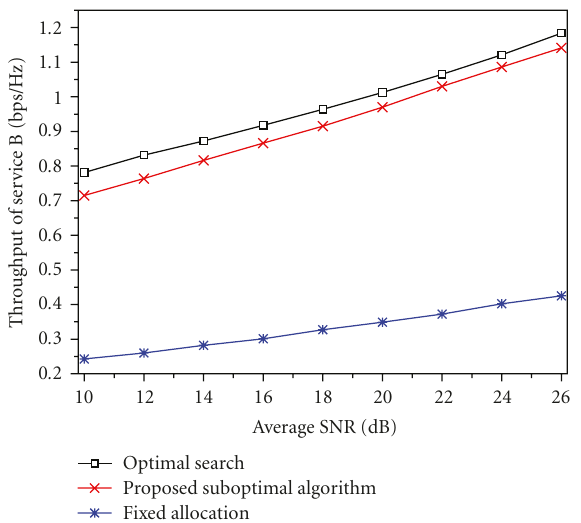
Figure 5: Throughput of service B (service A’ required rate R = 1.5bps/Hz).